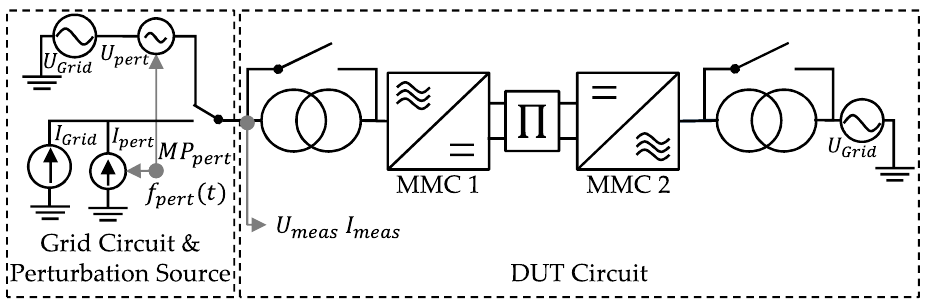
Figure 4. Circuit diagram of the MMC impedance derivation setup.